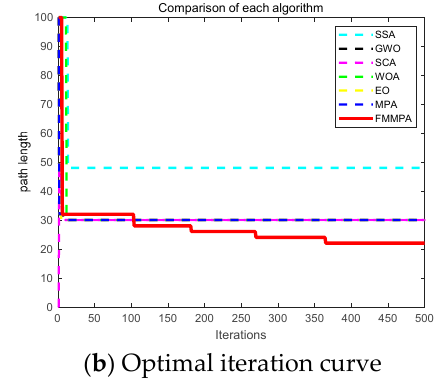
( b ) Optimal iteration curve Figure 9. Experimental results for map 3.